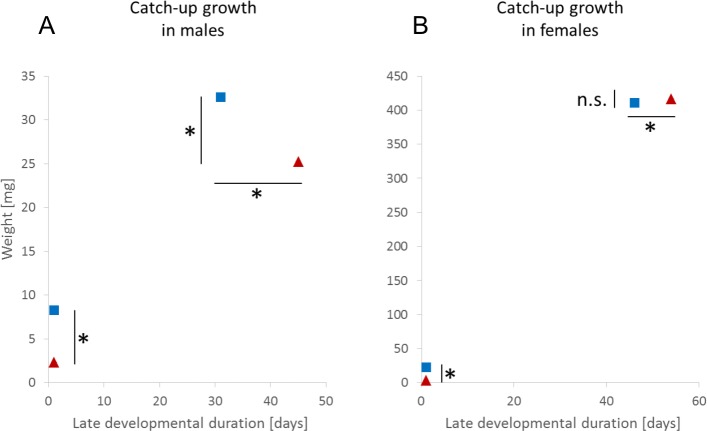
Adaptive catch-up growth in (A) male and (B) female Nephila senegalensis.Symbols indicate median values for body mass at the beginning of the late-experiment development and body mass at sexual maturation in treatments High-High (blue squares) and Low-High (red triangles). Late-experiment development in the High-High treatment followed four weeks of early high feeding conditions. Late-experiment development in the Low-High treatment followed four weeks of early low feeding conditions. Body mass is given as a proxy of body size (*, indicates significant differences).